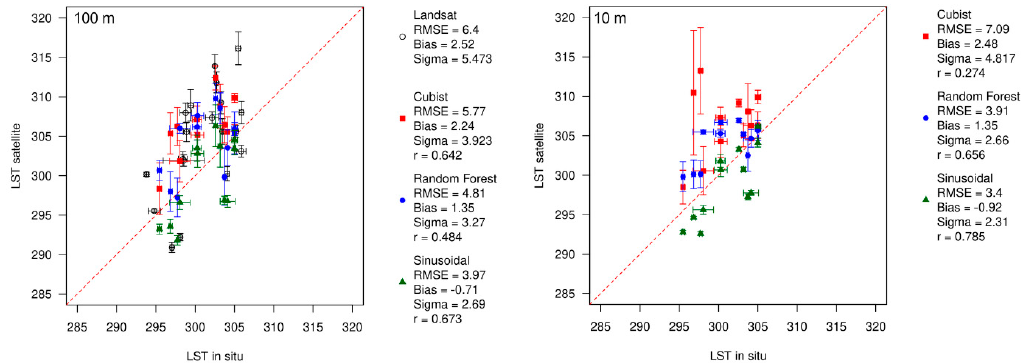
Figure 3. Validation results of the predicted LST with cubist, random forest, and sinusoidal models versus the LST measured by in situ stations.